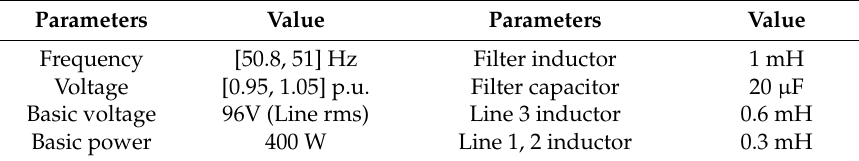
Figure 13. Experimental prototype setup of an AC MG.